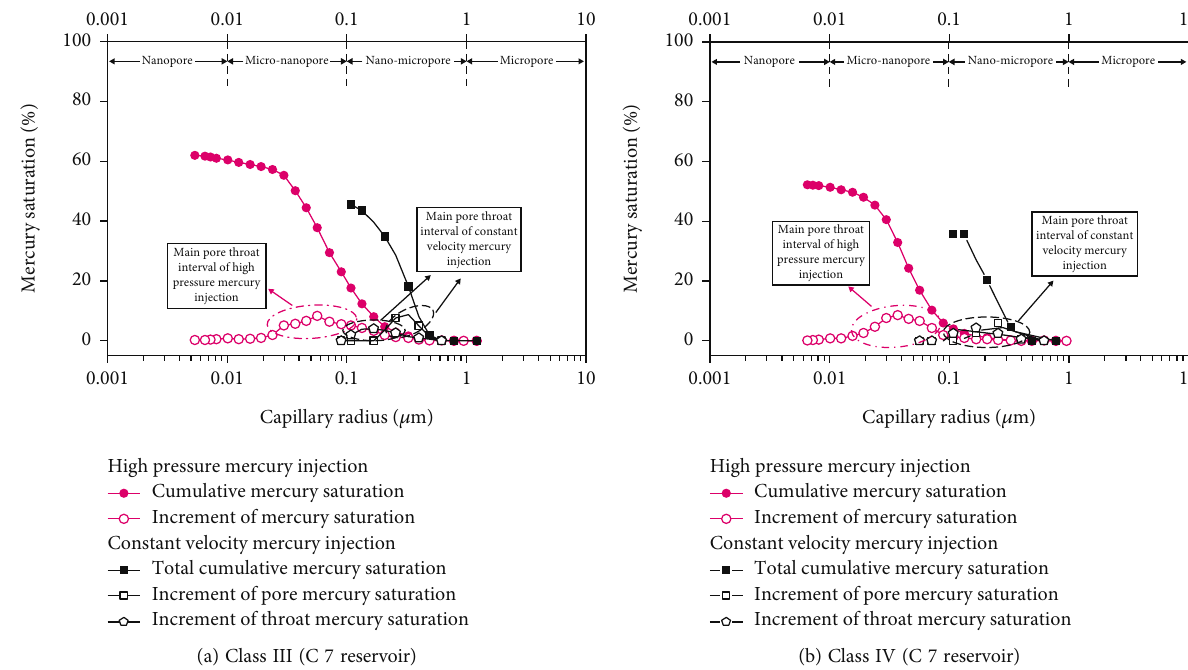
Figure 10: Superposition diagram of pore throat distribution and cumulative mercury saturation curve of C 7 reservoir. Table 1: Typical parameters of micropore structure (displacement pressure and mercury